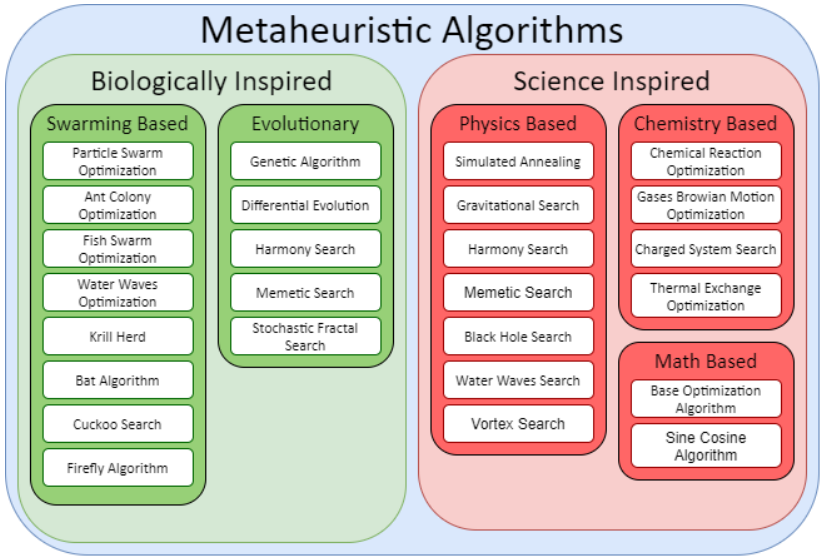
Figure 1. Classifications of Different Metaheuristic Algorithms. Compiled using information from